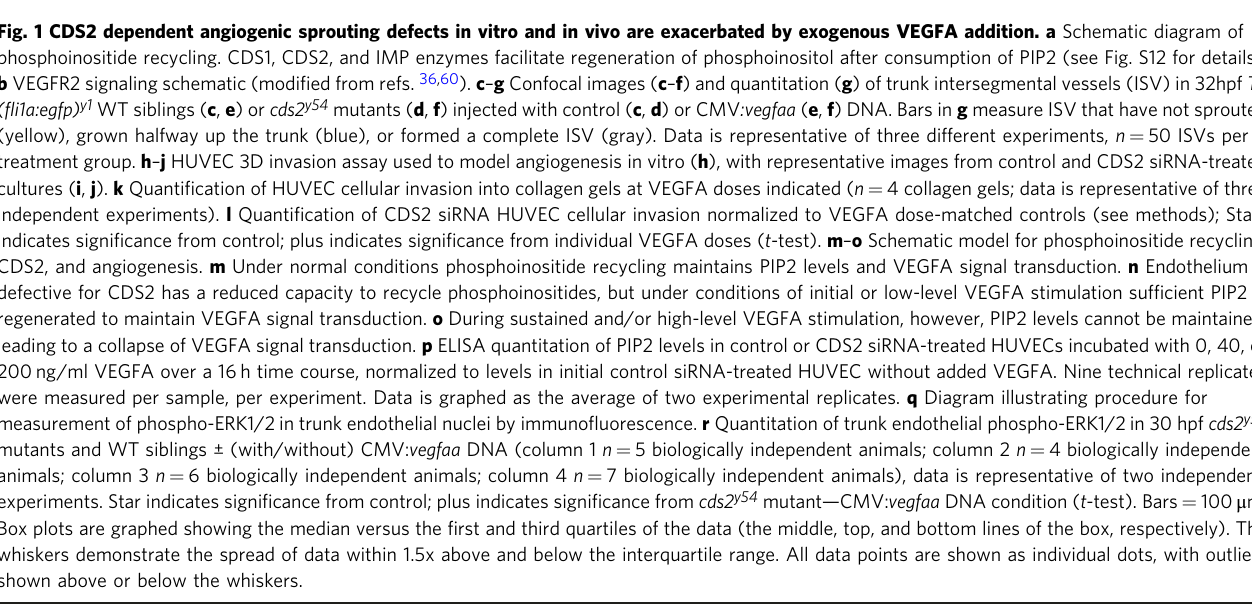
Fig. 1 CDS2 dependent angiogenic sprouting defects in vitro and in vivo are exacerbated by exogenous VEGFA addition. a Schematic diagram of phosphoinositide recycling. CDS1, CDS2, and IMP enzymes facilitate regeneration of phosphoinositol after consumption of PIP2 (see Fig. S12 for details). b VEGFR2 signaling schematic (modi fi ed from refs. 36,60 ). c – g Confocal images ( c – f ) and quantitation ( g ) of trunk intersegmental vessels (ISV) in 32hpf Tg ( fl i1a:egfp) y1 WT siblings ( c , e ) or cds2 y54 mutants ( d , f ) injected with control ( c , d ) or CMV :vegfaa ( e , f ) DNA. Bars in g measure ISV that have not sprouted (yellow), grown halfway up the trunk (blue), or formed a complete ISV (gray). Data is representative of three different experiments, n = 50 ISVs per treatment group. h – j HUVEC 3D invasion assay used to model angiogenesis in vitro ( h ), with representative images from control and CDS2 siRNA-treated cultures ( i , j ). k Quanti fi cation of HUVEC cellular invasion into collagen gels at VEGFA doses indicated ( n = 4 collagen gels; data is representative of